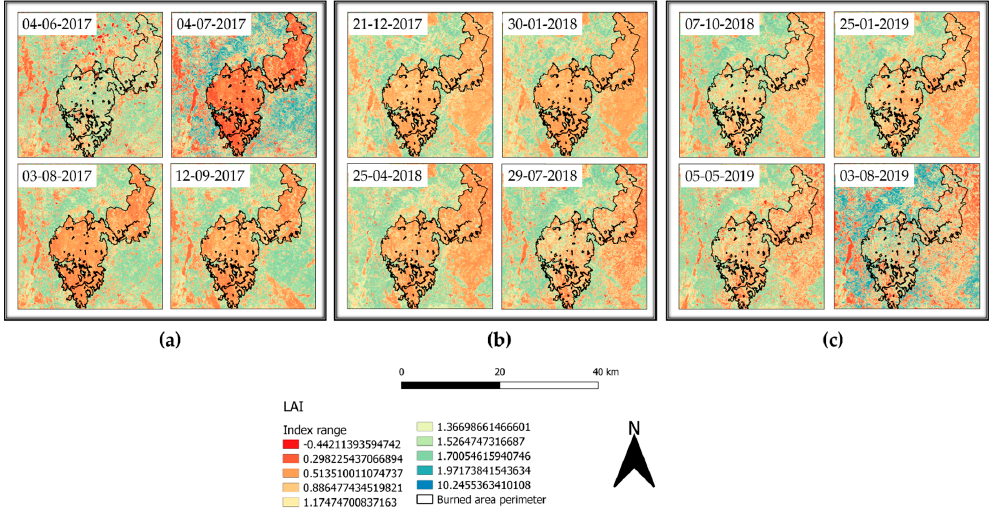
Figure 7. LAI index representation from 4 June 2017 to 3 August 2019.